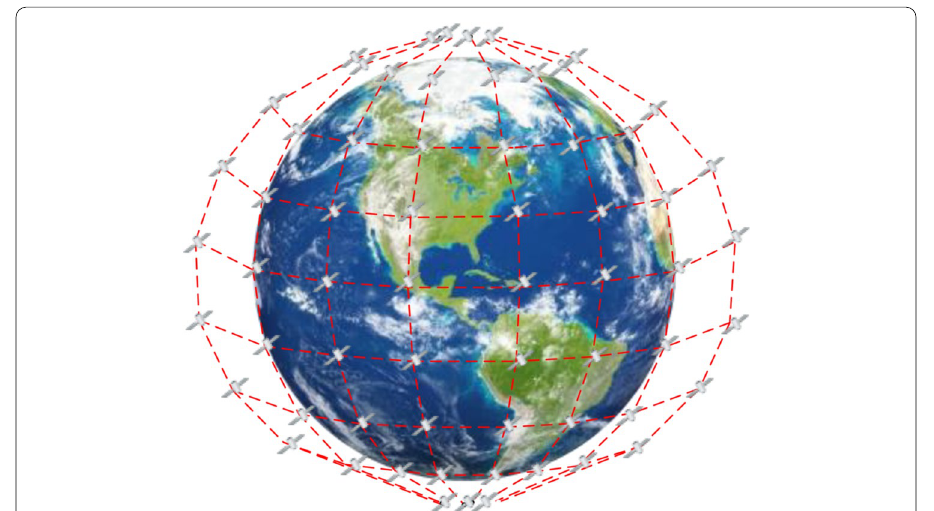
Fig. 1 LEO satellite communication